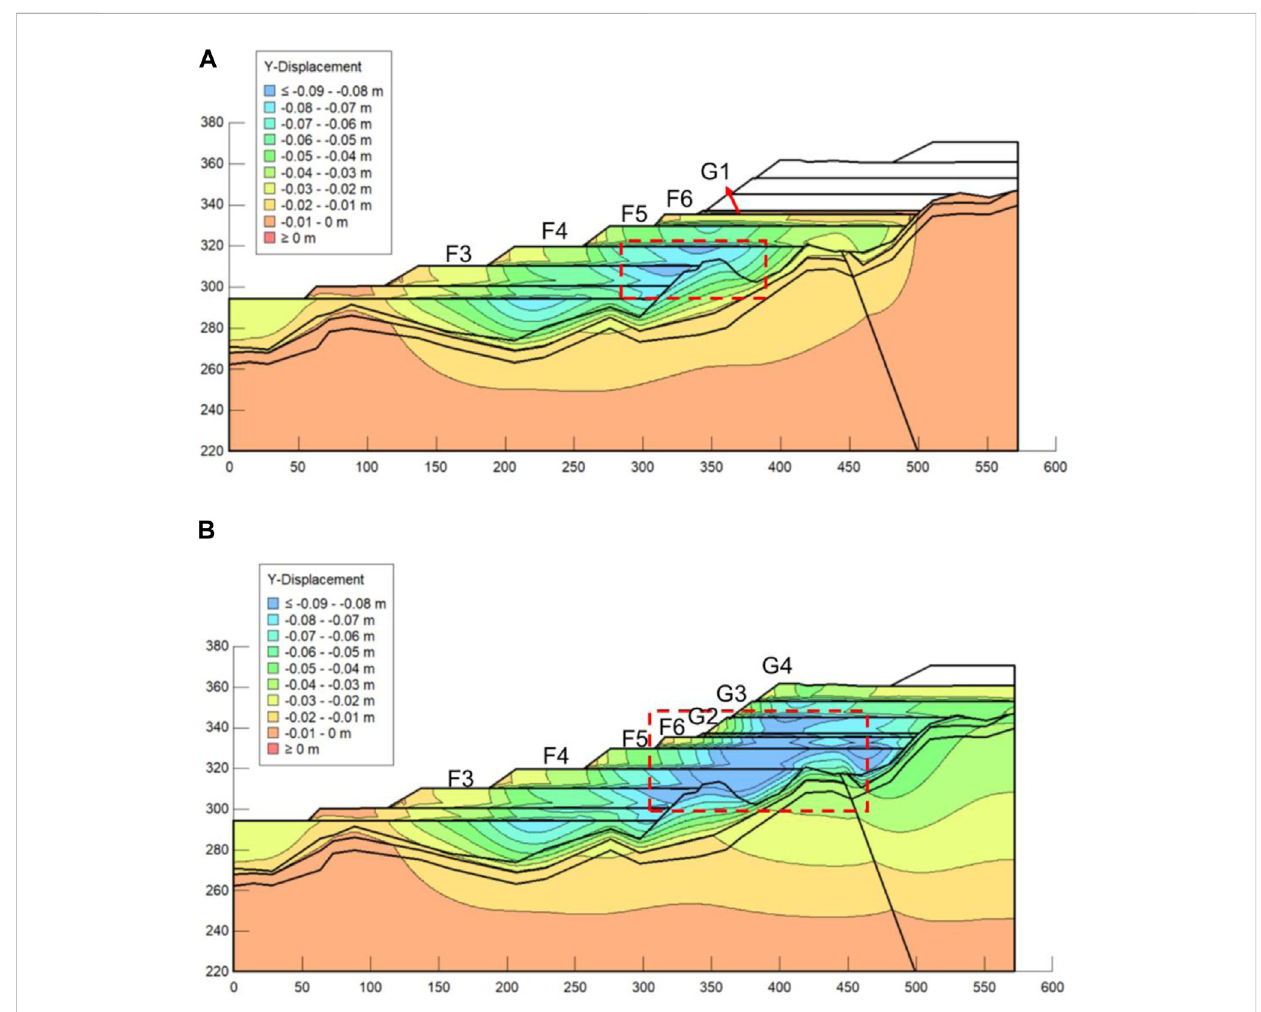
FIGURE 12 Cumulative displacement distribution contour of the high- fi lled deposit slope in the y-direction after the (A) G1; (B) G4 fi lling process.